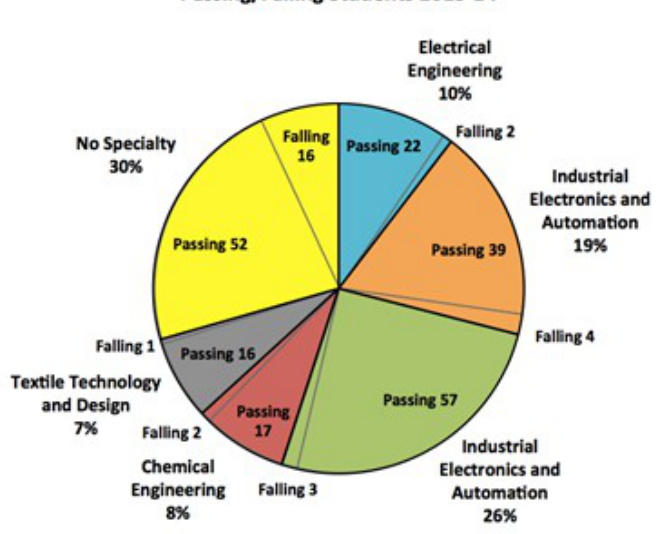
Figure 3. Percentage and number of passing/failing students by specialty. Academic year